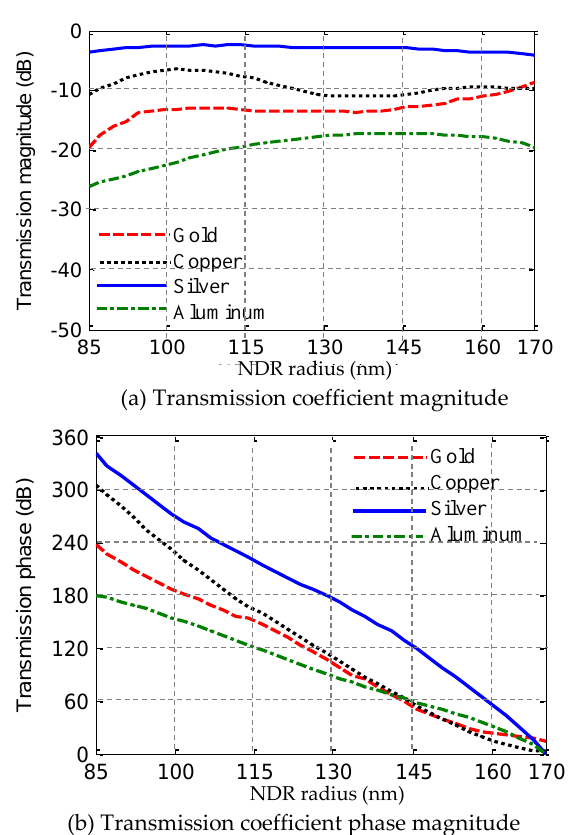
Figure 12 The variations of the transmission coefficient magnitude and phase of the NDR transmitarray unit cell with different supporting plane materials for h =50 nm, L =350 nm and h d =50